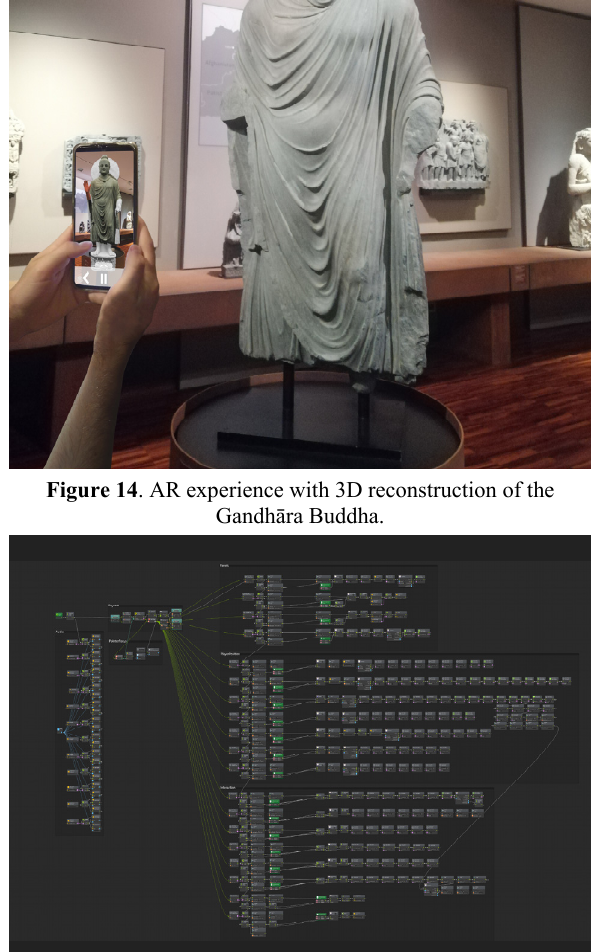
Figure 15 . VR application visual script on Unity® software with Bolt® plugin.